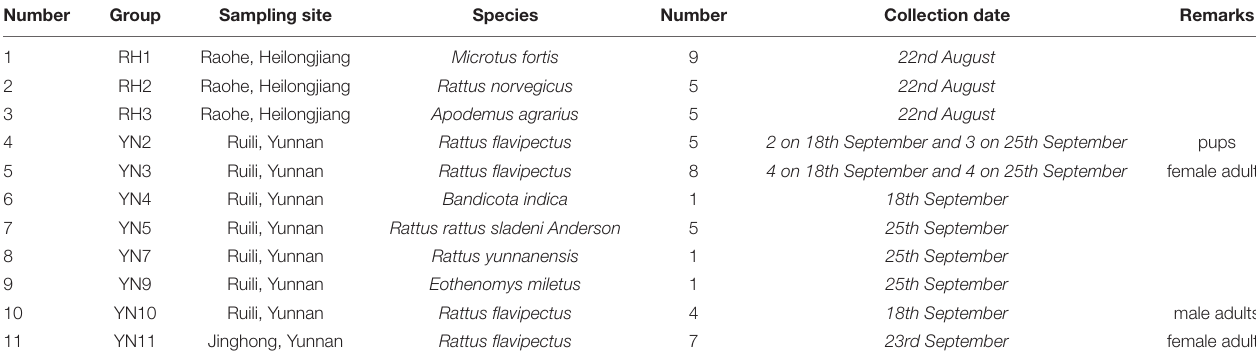
TABLE 1 | Groups of collected rodent specimens in Heilongjiang, Northeast China and Yunnan, Southwest